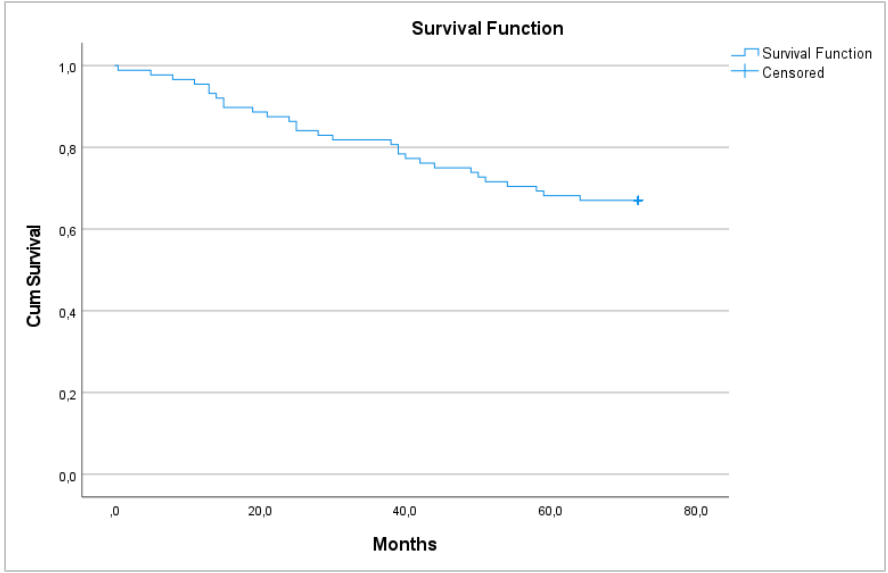
Figure 1. 6-year overall survival.